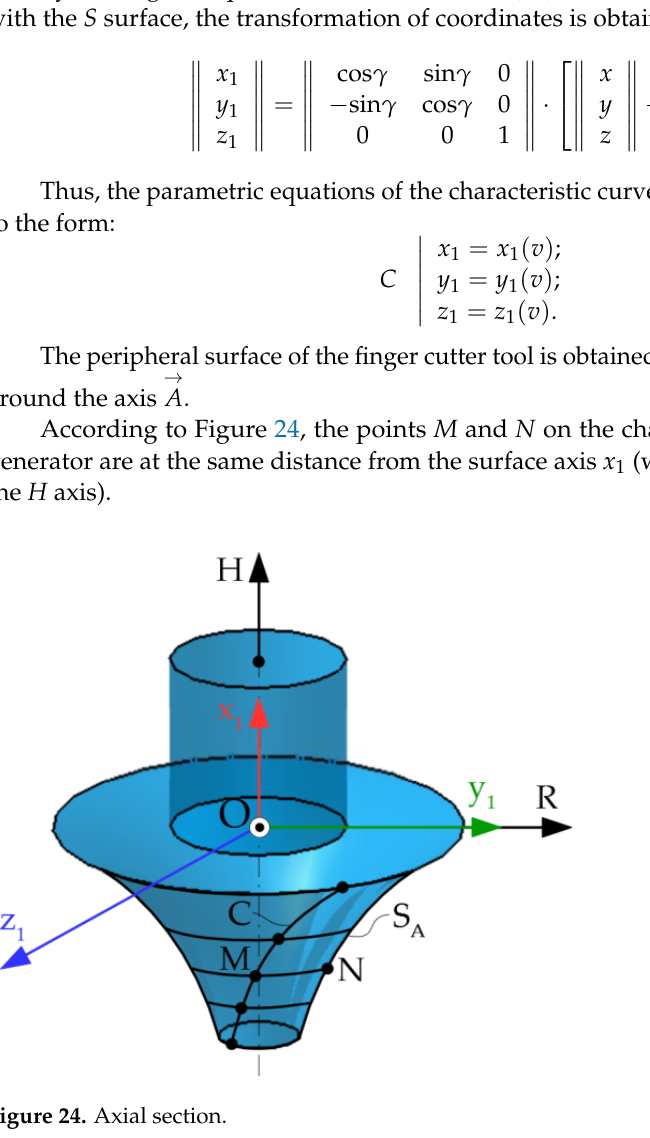
Figure 25. Generating with cylindrical tools.